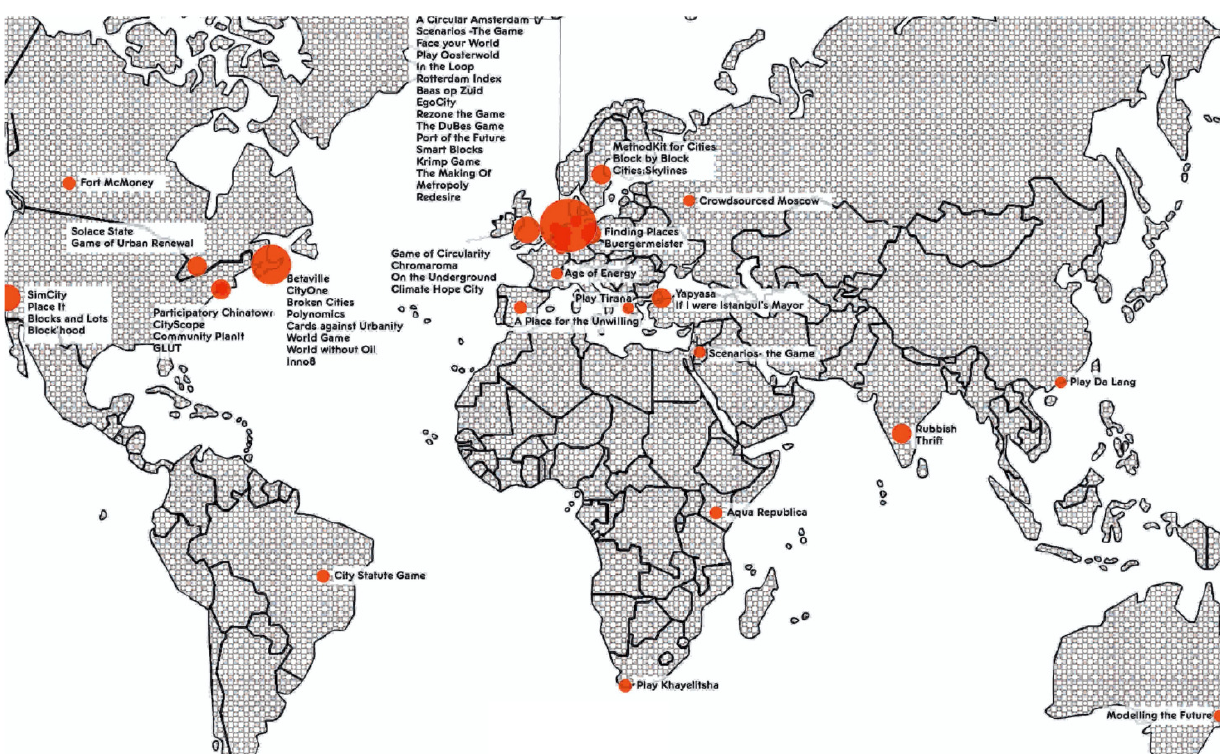
Figure 1. Map situating the city games worldwide as researched within the Games for Cities research